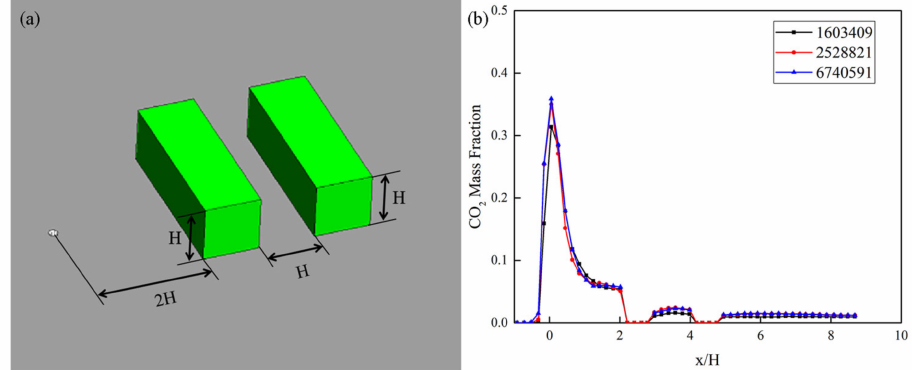
Figure 4. ( a ) Typical ideal street canyon model; ( b ) grid independent